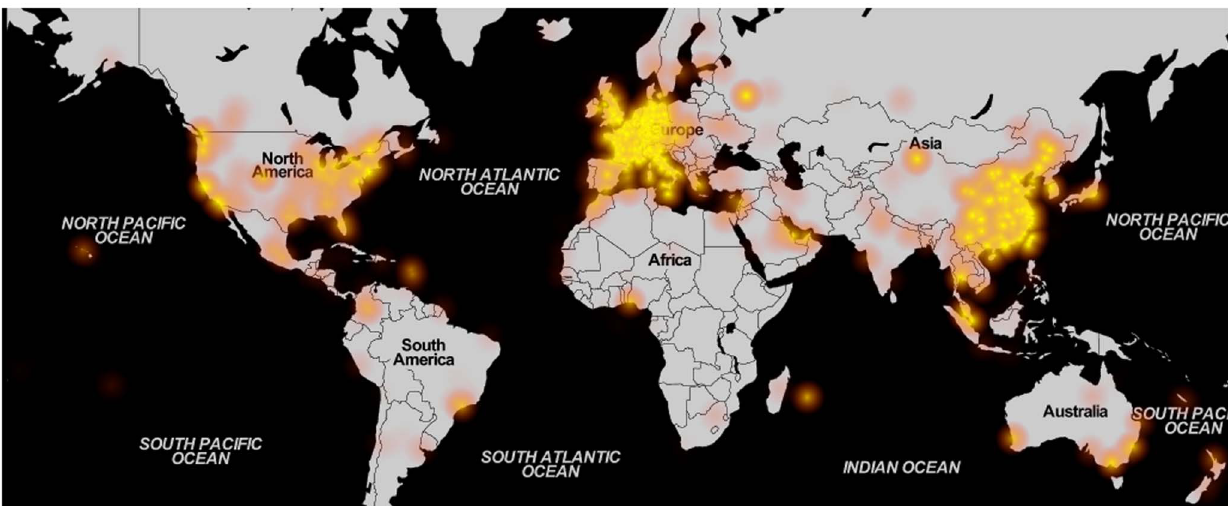
Figure 8. Overall heatmap. Worldwide sample density, including all measurements, illustrated as a heatmap ( (cid:2) OpenStreetMap contributors for map data, used and redistributed under the CC-BY-SA licence[26]).